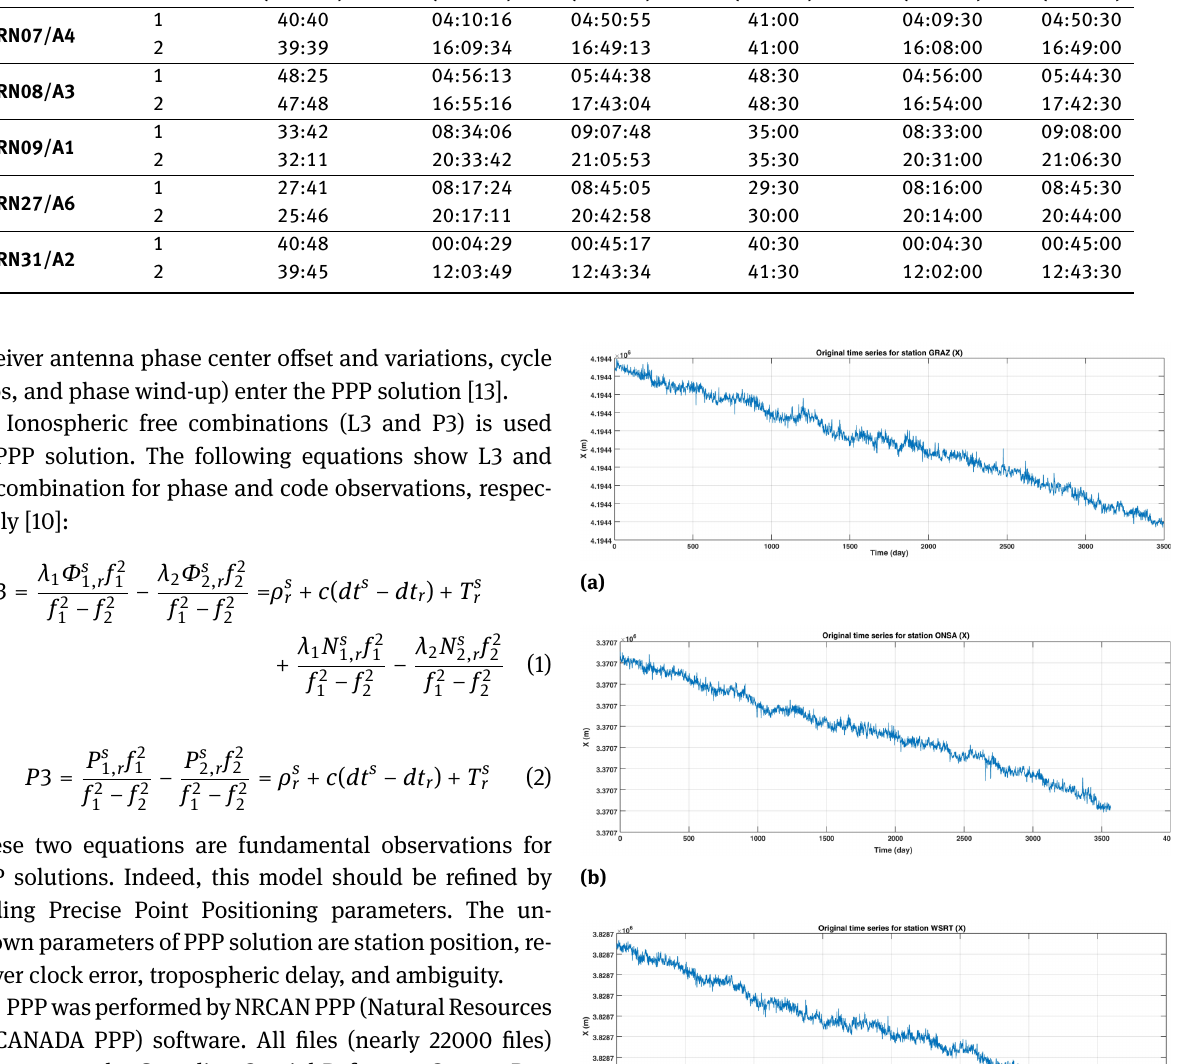
Table 1: Bernese and Toolbox results for satellites at shadow of the earth for 25 Apr 2011. Satellite/Plane Eclipse